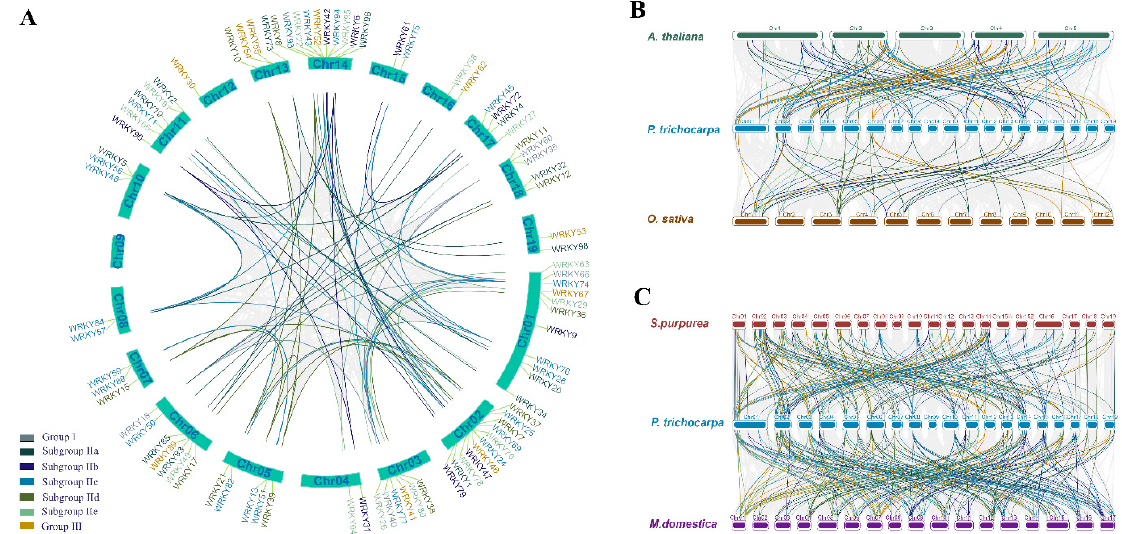
Figure 3. Intraspecific and interspecific collinearity analysis of WRKYs . Intraspecific collinearity of PtWRKYs ( A ). Interspecific collinearity analysis of PtWRKYs against Arabidopsis and rice ( B ), or against willow and apple ( C ).